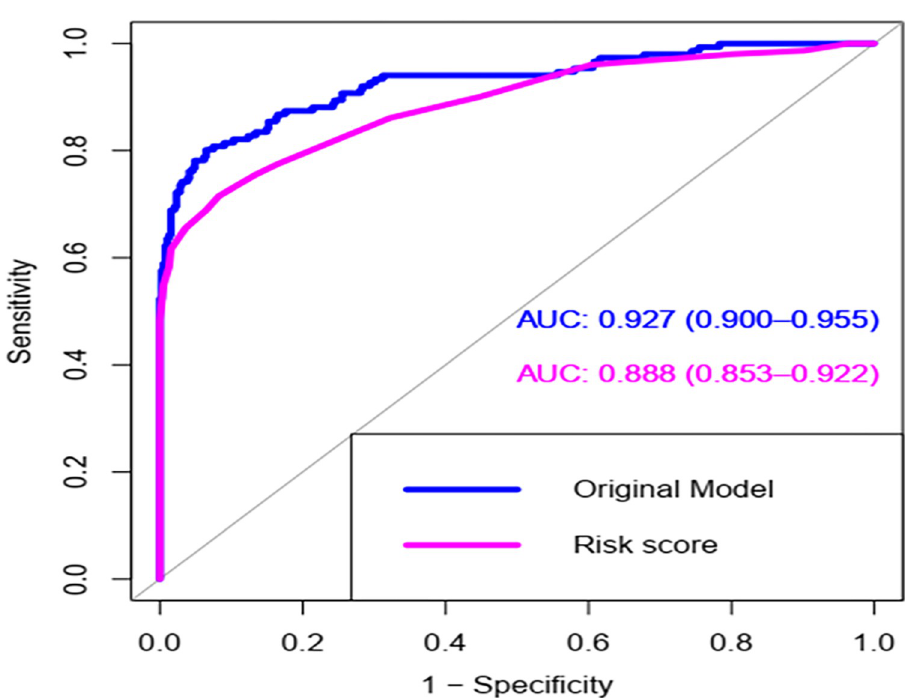
Fig 4. ROC curve for original β coefficient (blue curve) versus ROC curve for simplified risk score model (reddish-purple curve) for poor outcomes of SCAP in under-five children.